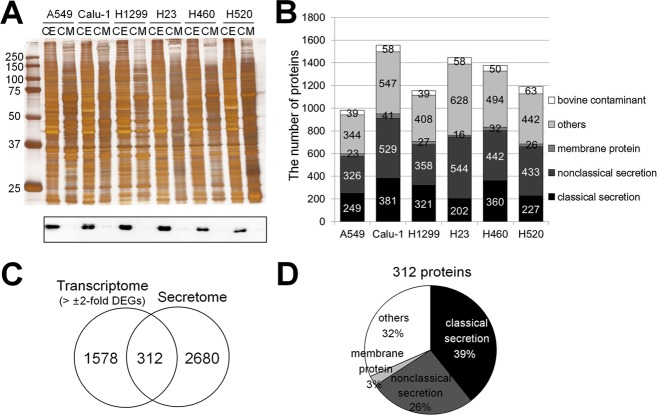
Analyses of conditioned media harvested from NSCLC cell lines.(A) Proteins (10 μg) in the conditioned media (CM) and cell extracts (CE) were analyzed by Western blot analysis using an anti-α-tubulin antibody. (B) The number of identified proteins in the cell secretome (FDR a 1%). Secretion pathways were predicted by SignalP, SecretomeP, and TMHMM. Bovine contaminants were distinguished using the human-FBS database. (C) Venn diagram of DEGs in tissues and identified proteins from cell secretomes. (D) Predicted secretion pathways of identified secretome proteins in all cell lines.